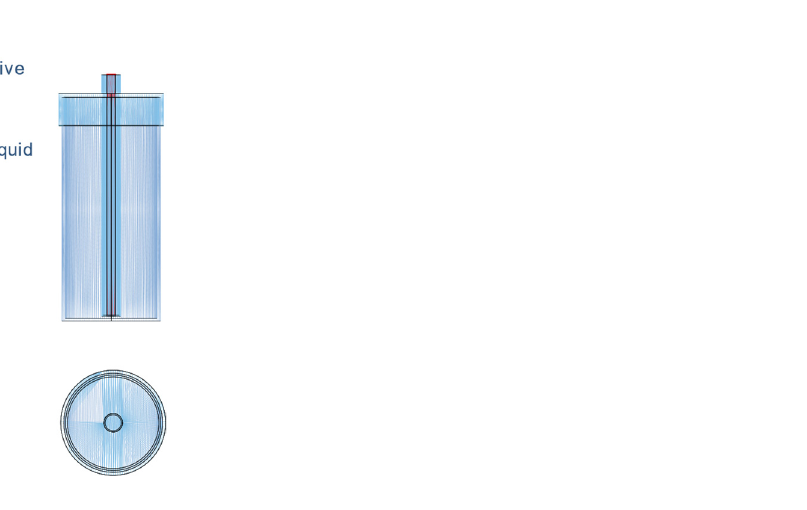
Figure 2. Basic sketch of the omnidirectional water projection device.